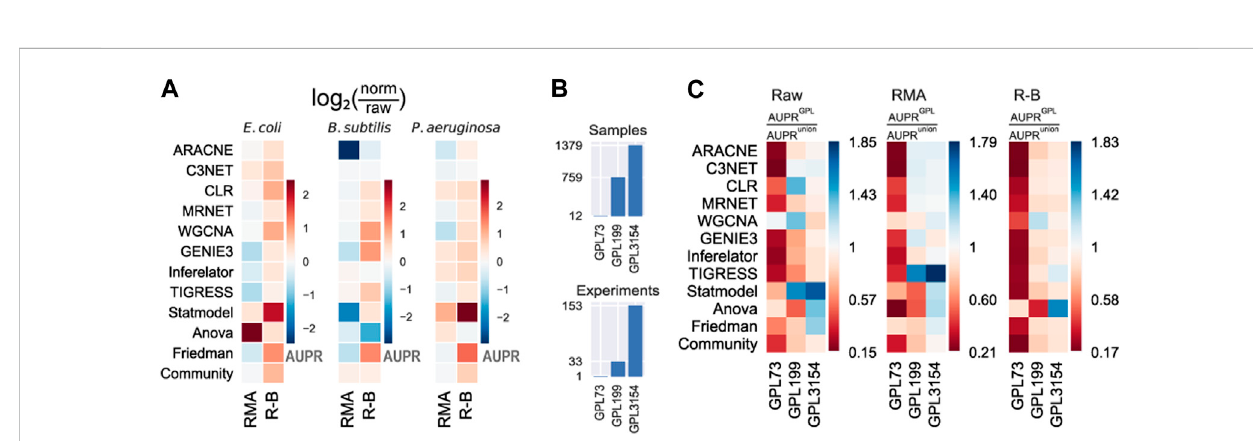
FIGURE 3 EffectofnormalizationandbatchcorrectionontheGRNinferencewithbiologicaldata. (A) RMAnormalizationwithbatchcorrection(R – B)presents a slight improvement over only RMA normalization. The values represent the log2 ratio of the AUPR with normalized data concerning the AUPR with raw data. Higher (warmer) values mean more signi fi cant improvement with normalization. (B) Platforms vary in the number of samples and experiments. (C) Methods were assessed using different Affymetrix platforms of E. coli and. AUPR increases with larger datasets as input